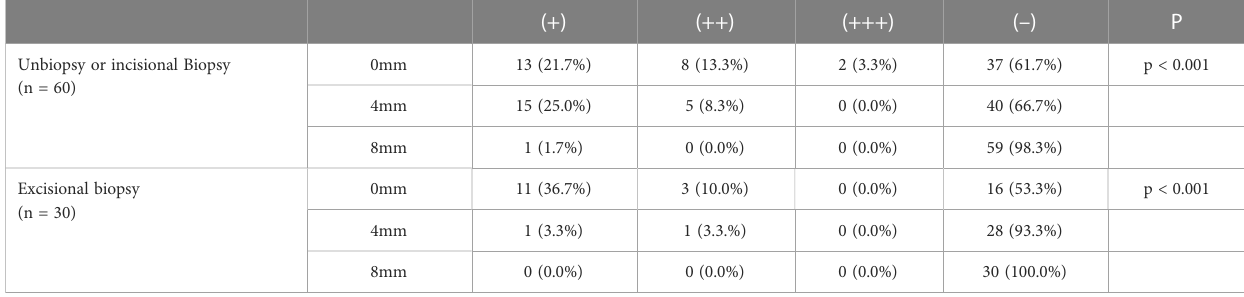
TABLE 4 Dermoscopy-detected cSCC peripheral borders with 0-mm, 4-mm and 8-mm excision margins and their corresponding postoperative margins of